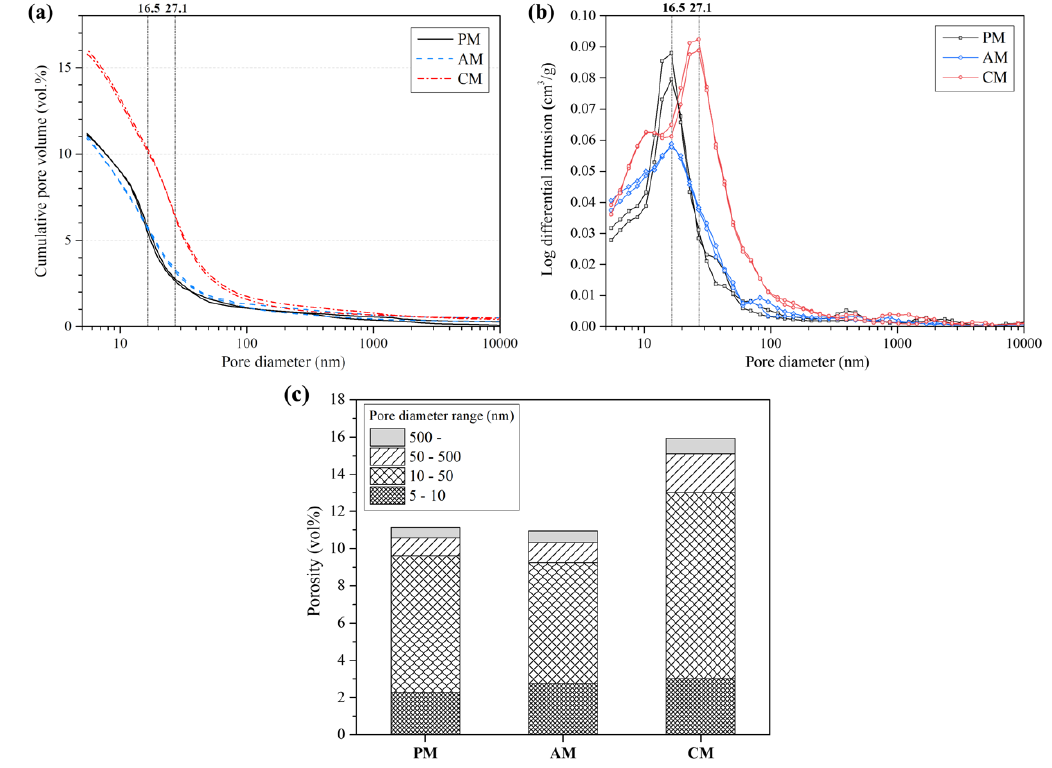
Figure 7. Mercury intrusion porosimetry (MIP) results of the mortar PM, AM and CM: ( a ) Cumulative pore volume; ( b ) Log differential pore volume; ( c ) Porosity according to the pore diameter range.